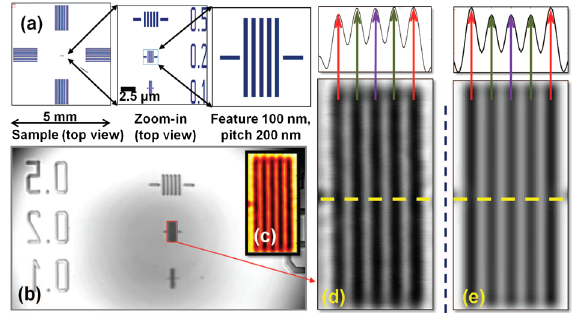
FIG. 2. Our result showing a resolution of 100-nm half-pitch feature. The image obtained using our system for the Tedpella Inc. ’ s critical dimension calibration or resolution target (a) is shown in (b). The zoom-in of the image of the second feature with 100-nm half pitch is shown in (d). An artificially colorized image is included in (c) for convenient visualization. A simulated image [15] of the feature is shown in (e). The normalized intensity (inverted) at the cross-section lines shown in (d) and (e) are plotted above